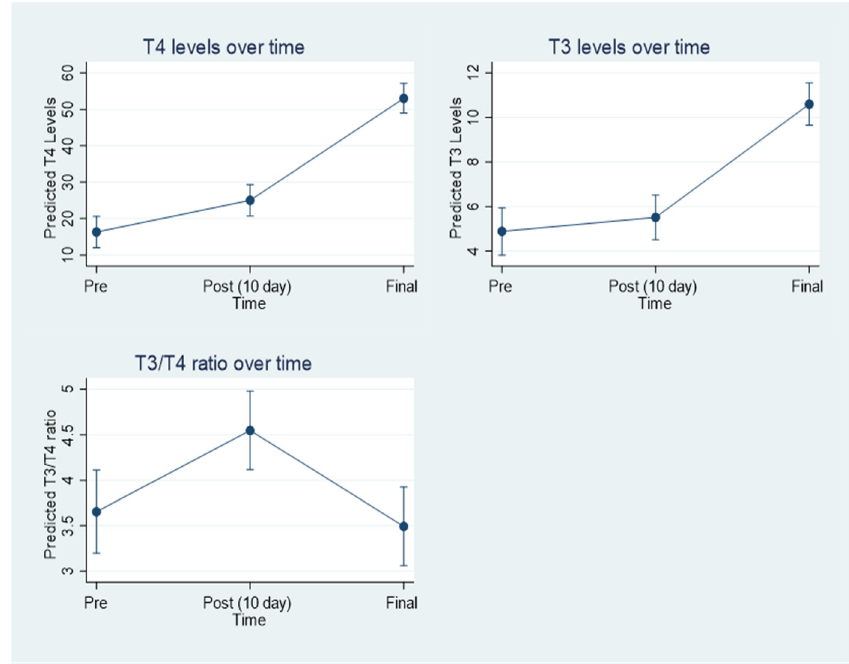
Figure 2. Shows the marginal means of T3 and T4 levels and T4/T3 ratio of the multilevel modelling analyses for pre, post, and final observation times.